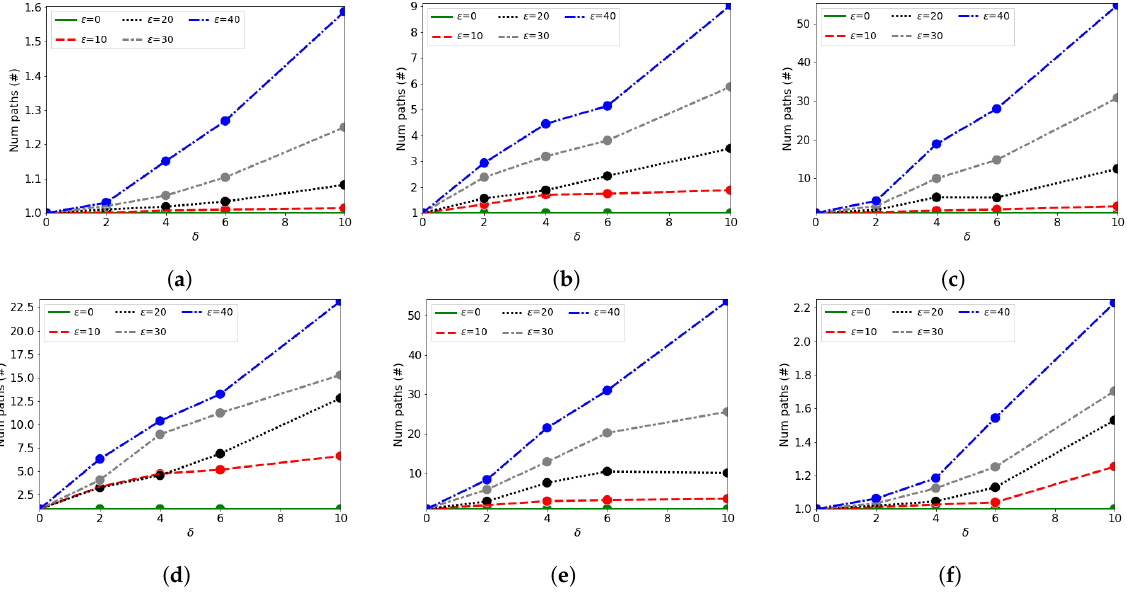
Figure 5. Number of paths in different cities, varying (cid:101) and δ . The cities tested are Bologna, Italy ( a ), Austin, Texas ( b ), Marrakech, Morocco ( c ), Manila, Philippines ( d ), Buenos Aires, Argentina ( e ), and Auckland, New Zealand ( f